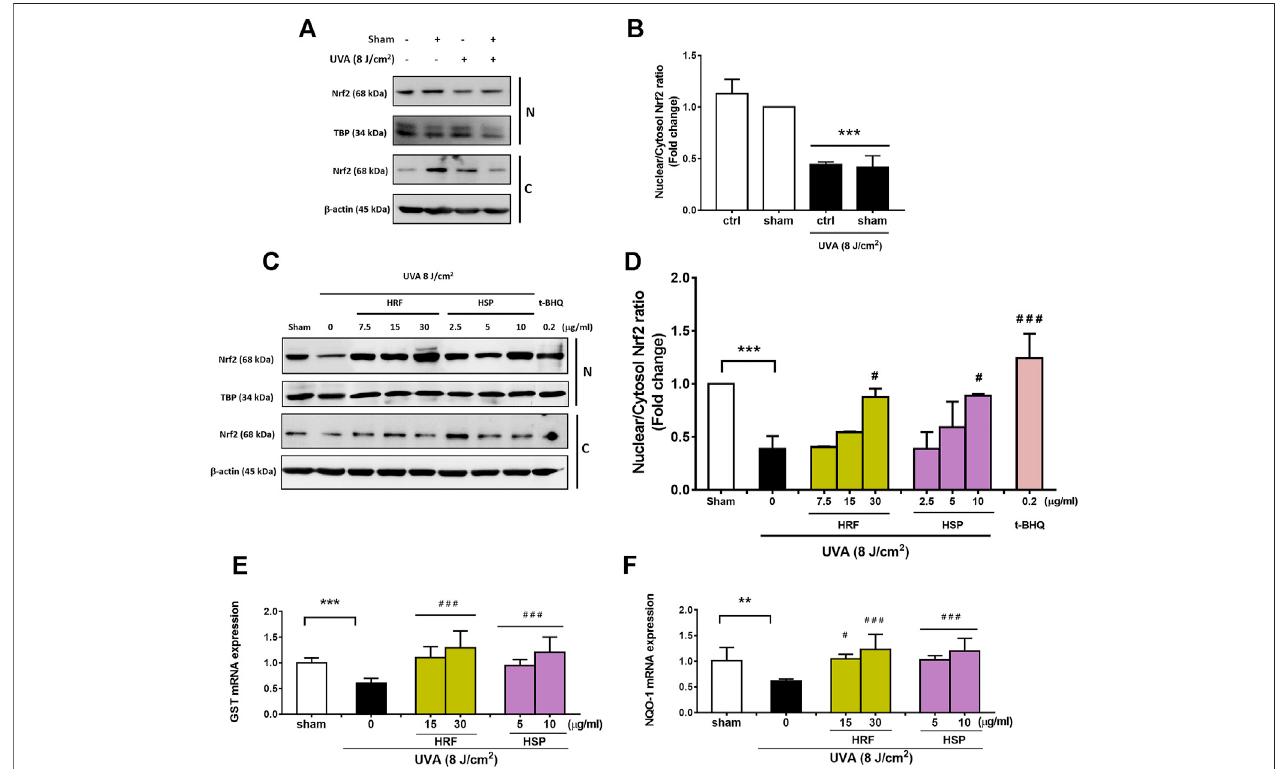
FIGURE 3 | The photoprotective role of HRF and its active ingredient HSP involved the Nrf2-regulated redox balance. Following 1 h UVA (8 J/cm 2 ) irradiation, NHDFswereharvestedtoperformthewesternblotanalysisofNrf2nucleartranslocation(thenuclear-to-cytosolicNrf2ratio)anditsdownstreamantioxidantgenes(%of control). The representative blot pictures (A) and the summary graph analysis of the UVA irradiated cells compared to unirradiated control (ctrl) cells and ethanol treatment in irradiated cells (B) . The representative blot pictures of each treatment group (C) and the summary graph analysis of the treatment group (D) .